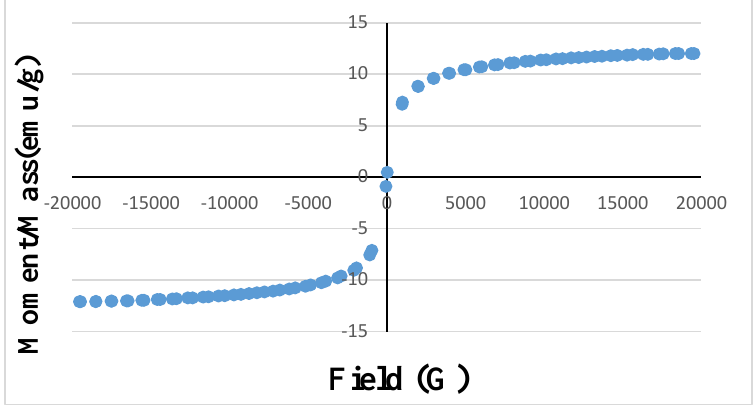
Figure 4. Magnetization curves of magnetic ZnO nanotubes.